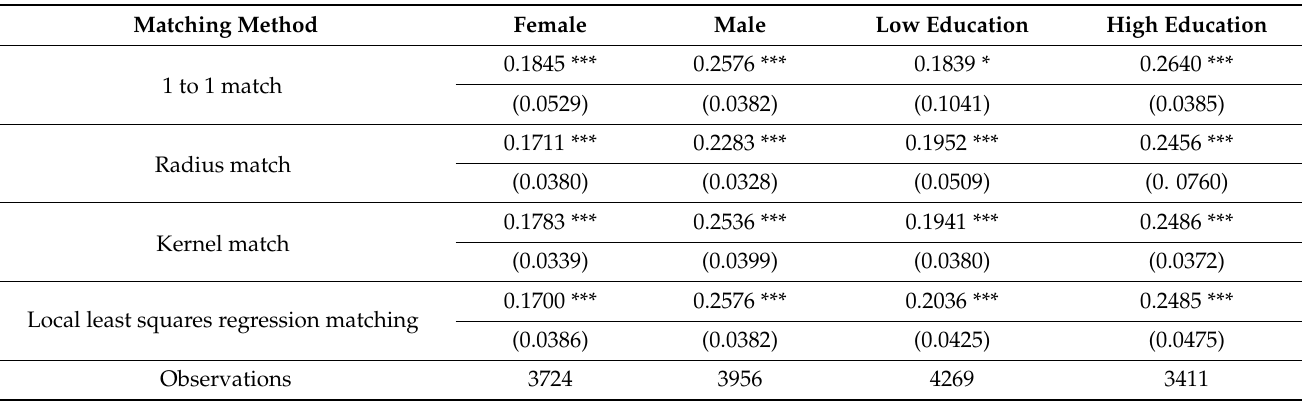
Table 7. Results of the heterogeneity